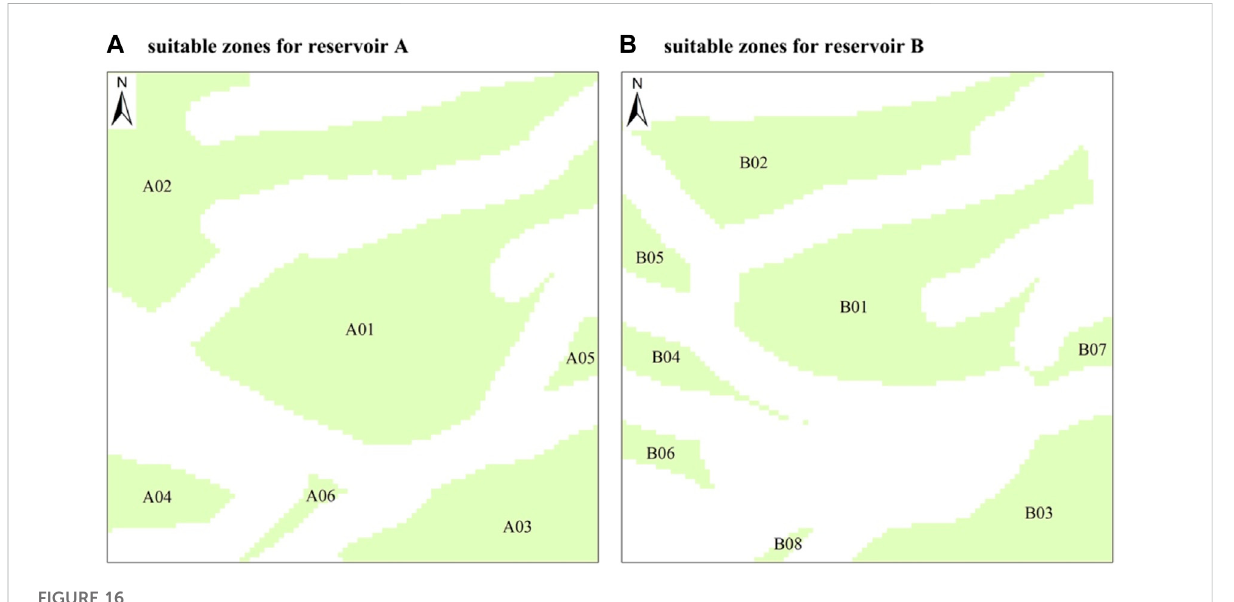
FIGURE 16 CO 2 geological storage potential maps of